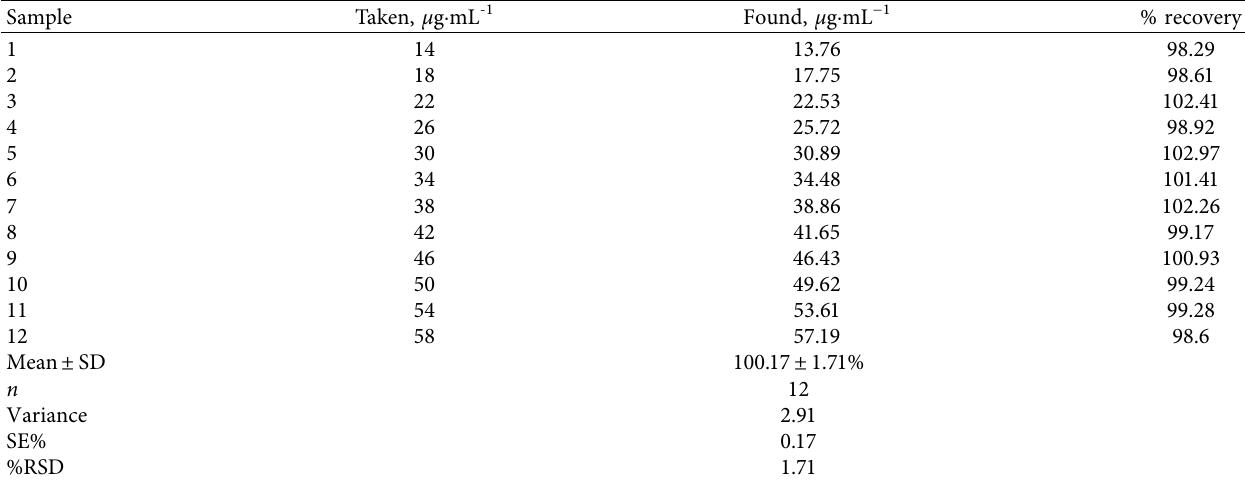
Table 4: Analytical parameters for the determination of LD.